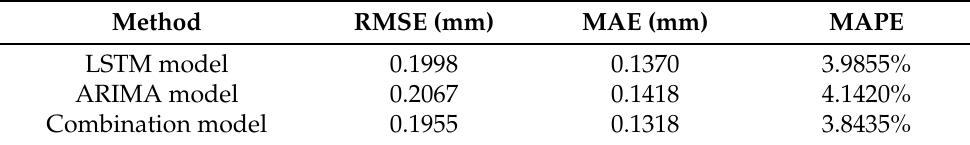
Table 3. The evaluation indicators of the prediction